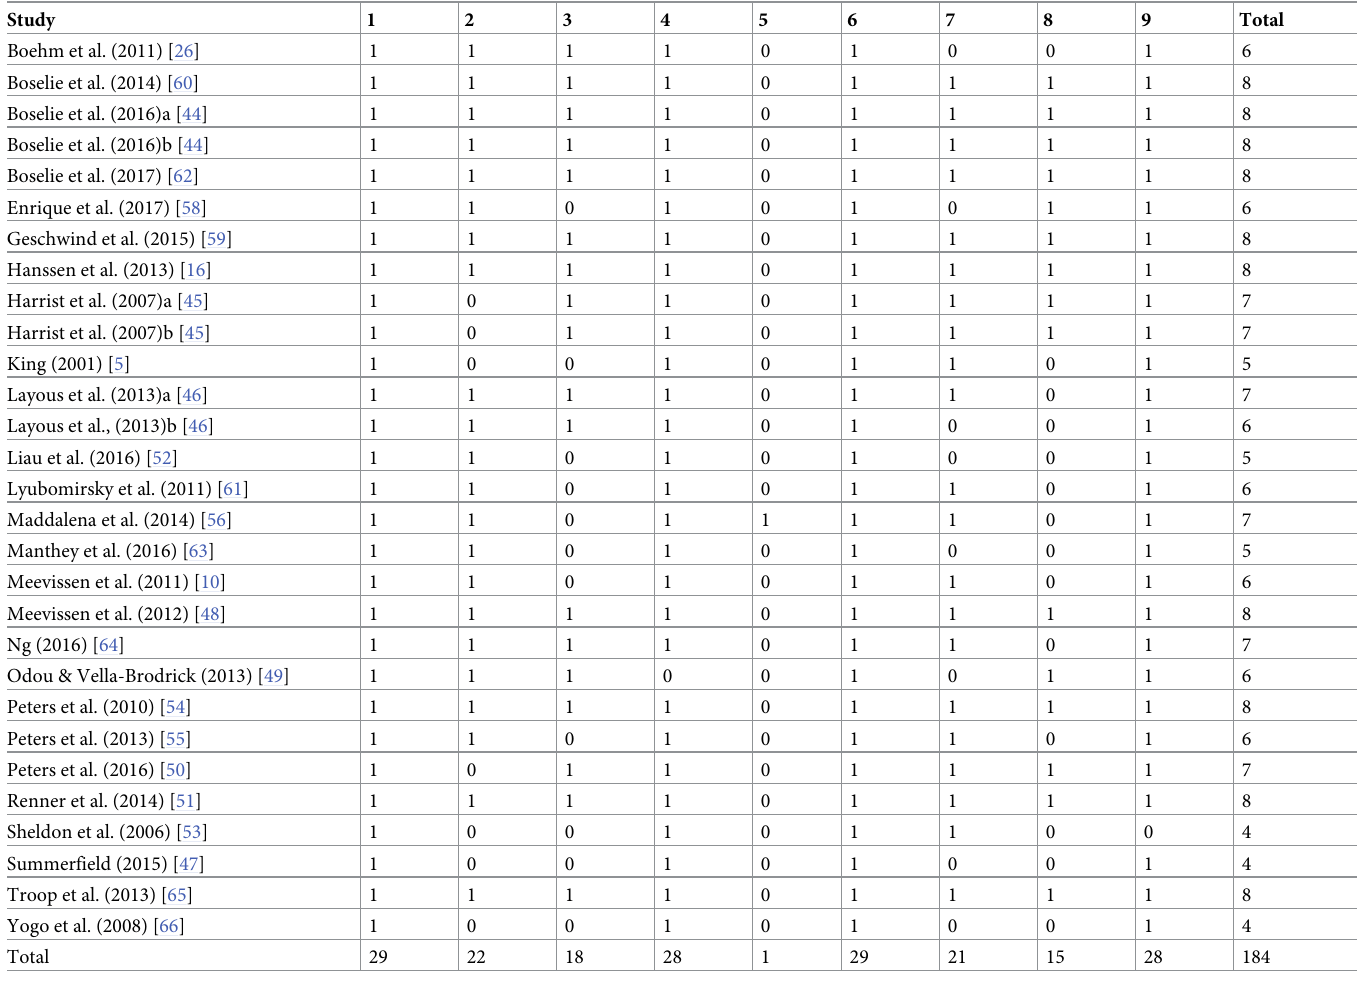
Table 2. Quality assessment per